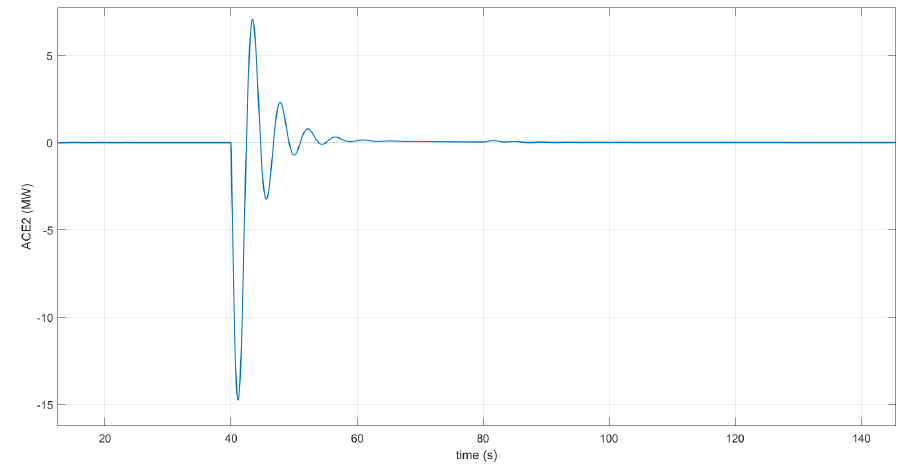
Figure 17. The area control error of area